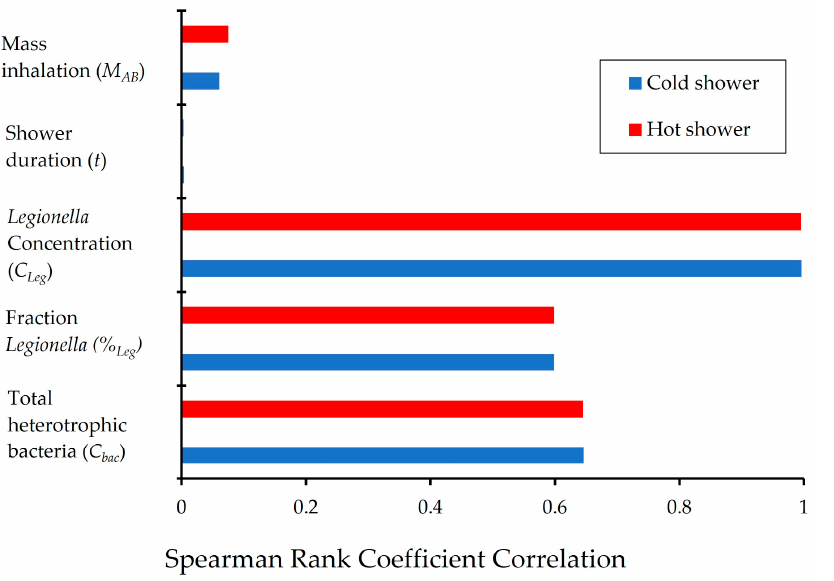
Figure 5. Sensitivity analysis for annual infection risk by scenarios and input parameters as defined in Table 1.